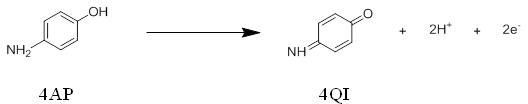
Oxidation reaction of 4-aminophenol (4AP) to 4-quinoneimine (4QI).